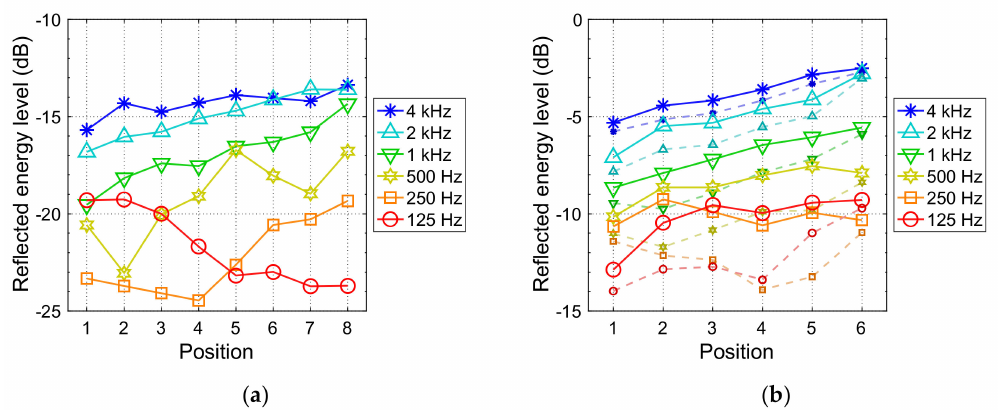
Figure 5. Reflected octave-band energy levels returned to the source position from FDTD simulation: ( a ) Panna Meena ka Kund (partial model, without ground reflection); ( b ) Lahan Vav (full model)—for which large markers include the ground reflection and small markers (dashed lines) exclude it. Values are expressed relative to the emitted free field energy at 1 m.